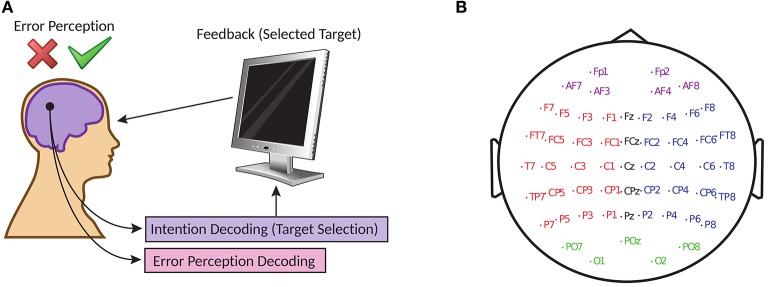
(A) Online error potential decoding framework in target selection with BCI (B) Electrode locations of the 56 channels arranged in extended 10–20 system.